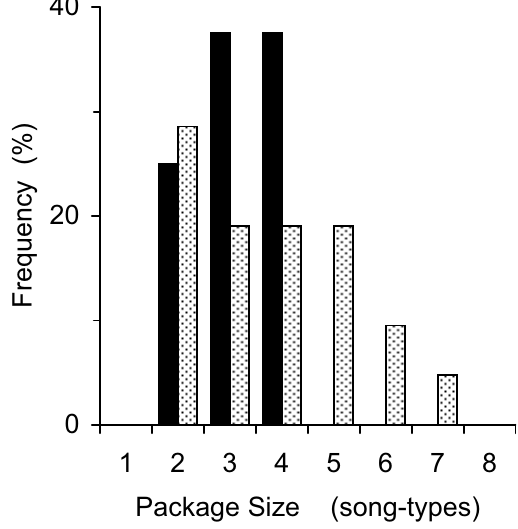
Fig. 4 – Frequency distribution of package sizes (given as num- ber of song-types) assessed in packages that spanned a longer temporal interval between master song-types (20s interval; black columns) or in packages developed from temporally ‘coherent’ string portions (4s interval; stippled columns). The latter sample does not include packages that had a boundary at the spaced out string